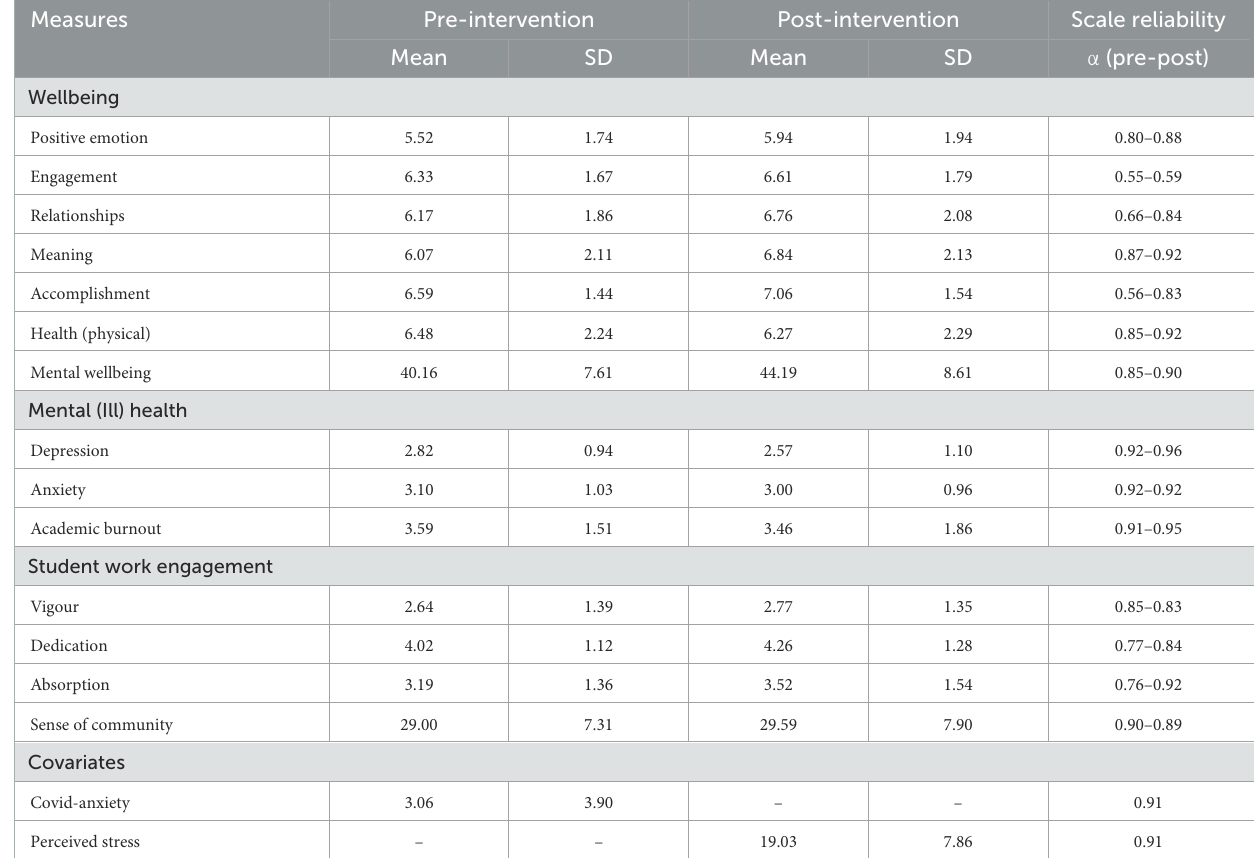
TABLE 3 Pre- and post-survey mean scores and reliability indicators across all outcome measures.